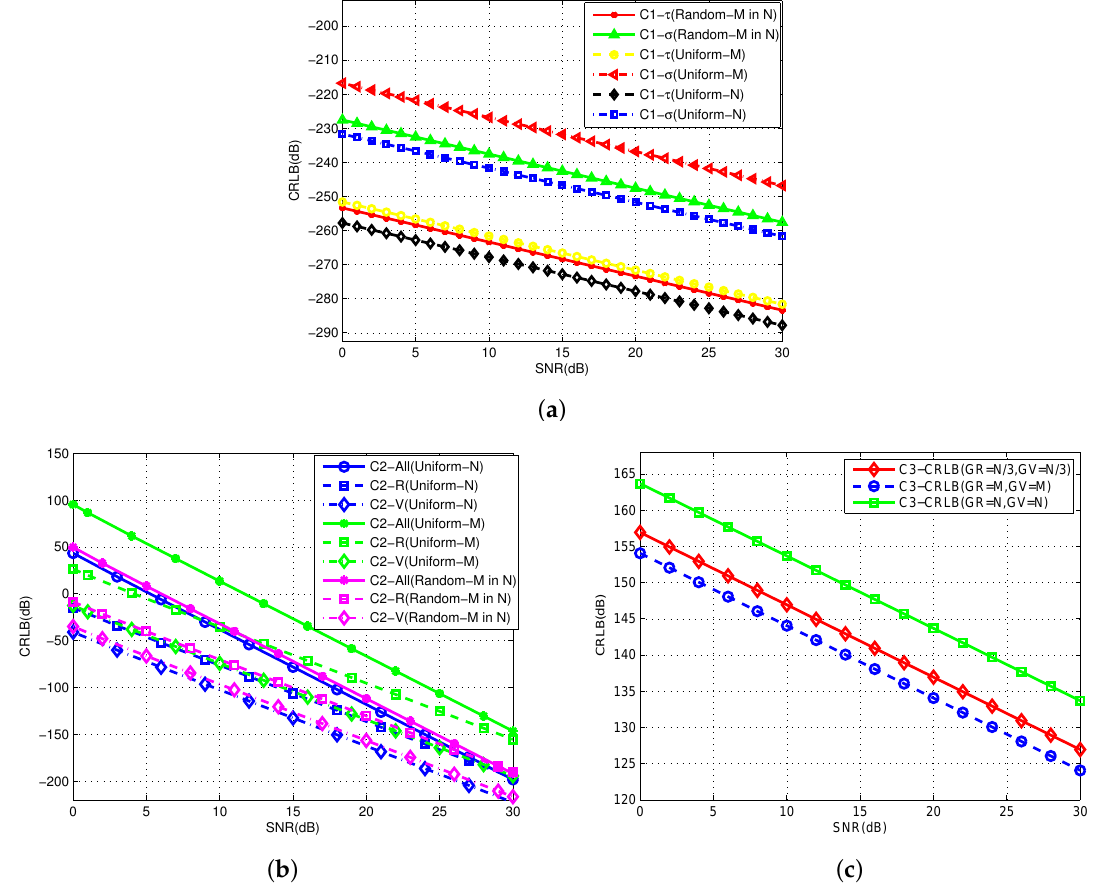
Figure 4. Comparison of CRLBs using different model. ( a ) CRLB using time delay and Doppler stretch estimator; ( b ) CRLB using multiple parameter estimator; ( c ) CRLB using the sparse based